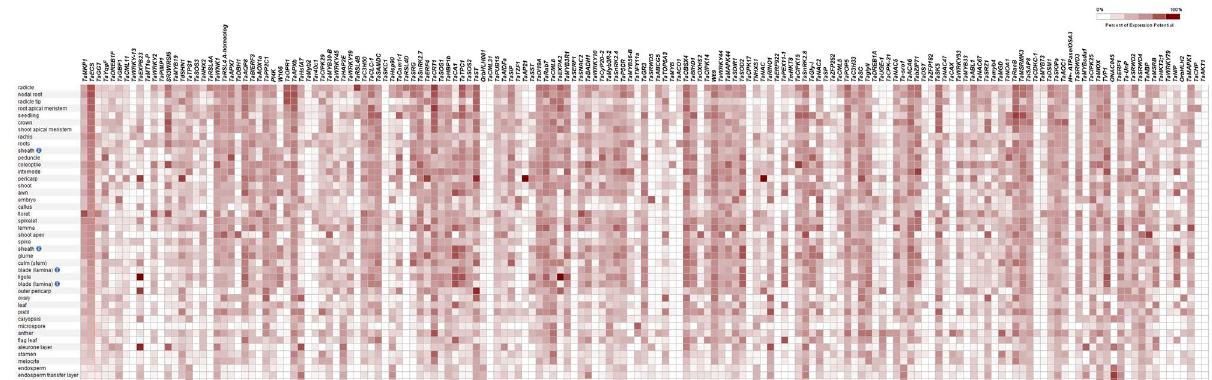
Figure 3. RNA-seq based tissue-specific expression profiles of salt stress responsive genes in wheat. ( A ) Expression profile. ( B ) Developmental stage-specific expression profile. The expression datasets were normalized and presented as heat maps using meta-analysis tool. The intensity of color represents the percent expression profile of the genes as described in the legend